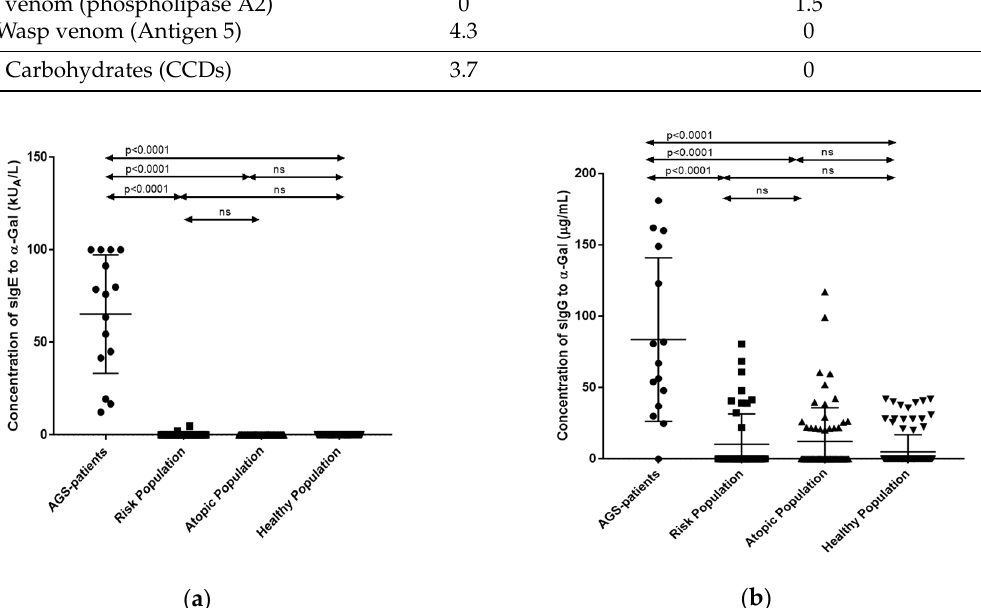
Figure 1. Concentrations of the sIgE ( a ) and sIgG ( b ) antibodies specific to α -Gal in the studied populations: AGS patients (circles) ; Risk Population (squares); Atopic Population (triangles up-ward); Healthy Population